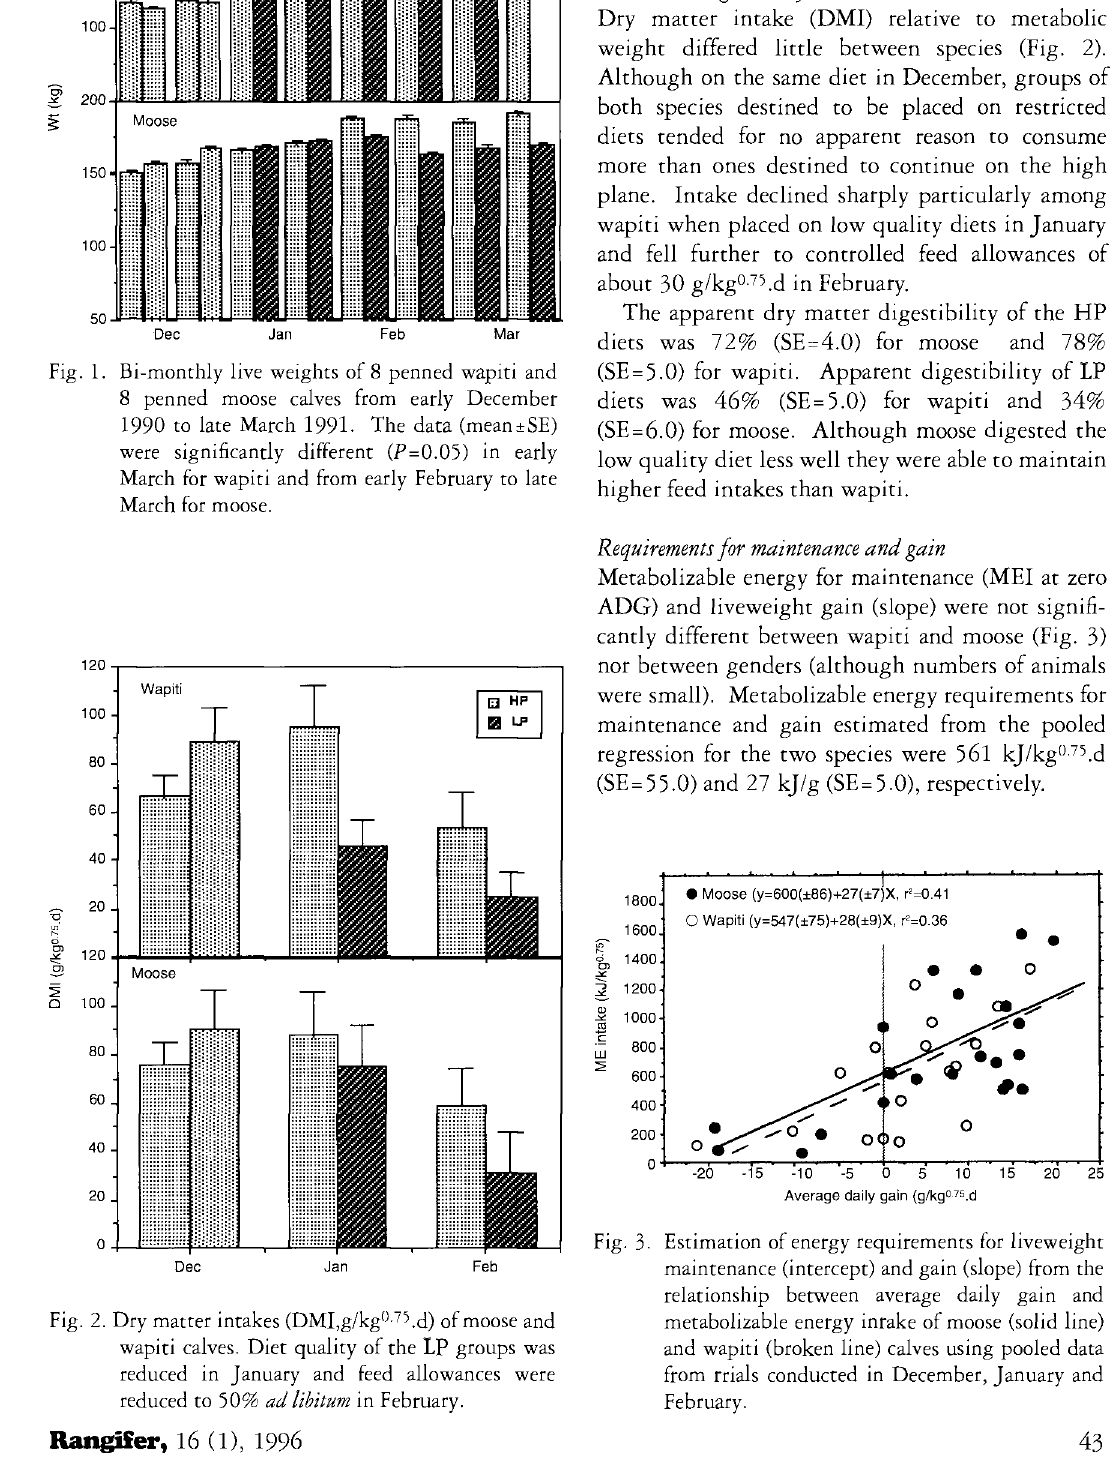
Fig. 3. Estimation of energy requirements for liveweight maintenance (intercept) and gain (slope) from the relationship between average daily gain and metabolizable energy inrake of moose (solid line) and wapiti (broken line) calves using pooled